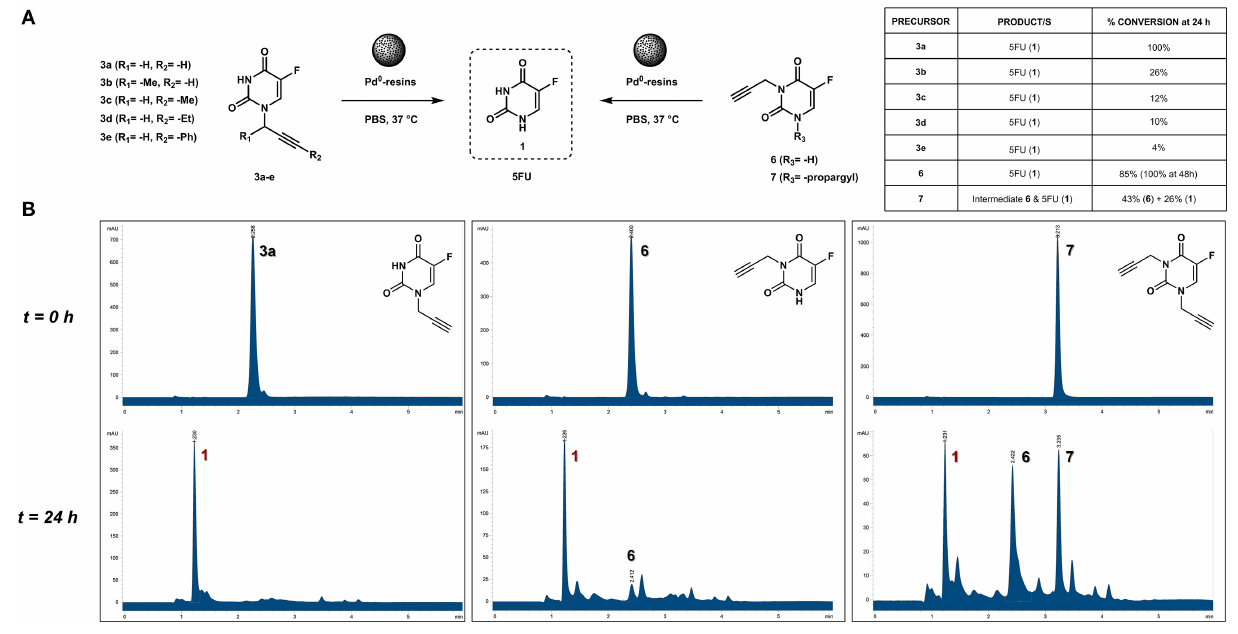
panel), and 7 (right panel) treated with Pd 0 -resins at 37 ◦ C for 0h (top) and 24h (bottom).